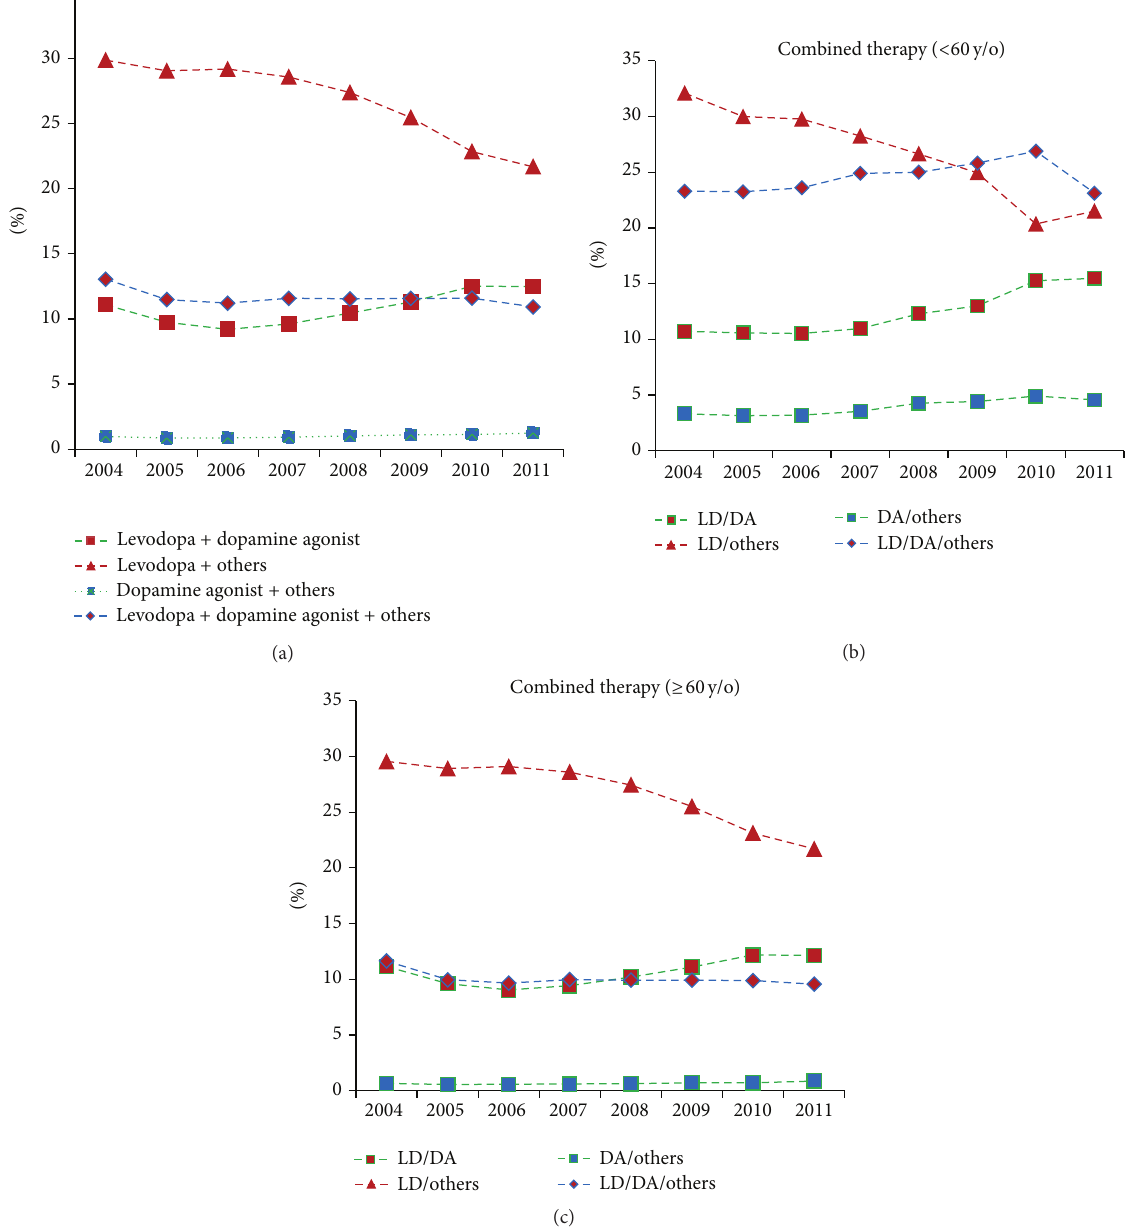
Figure 2: Timetrendsfor antiparkinsonismcombination therapy prescription patterns from2004 to 2011 forthetotal population (a)stratified by age < 60 years (b) or ≥ 60 years (c). LD: levodopa; DA: dopamine